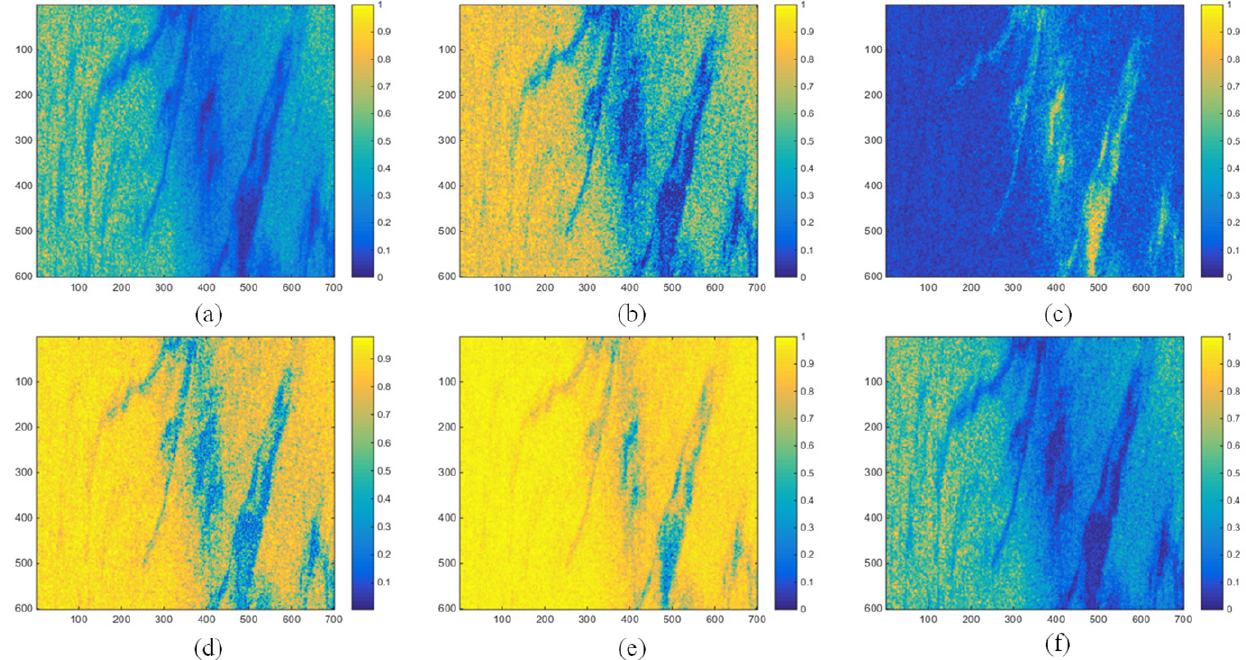
√ g 0 ; ( b ) 1 − H w ; ( b ) 1 − 𝐻 ; ( c ) (cid:3050) 0